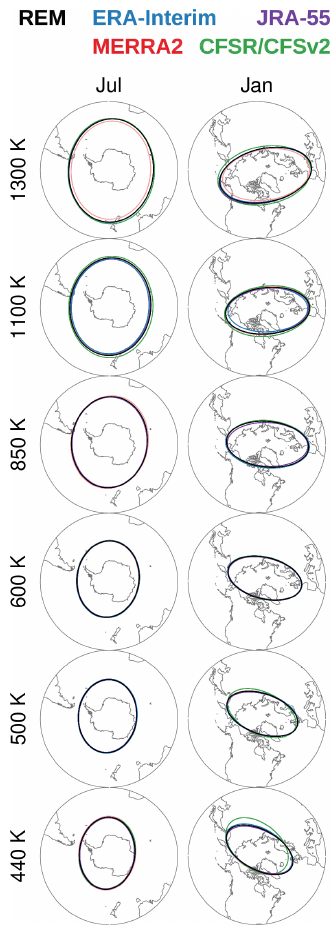
Figure 15. Polar stereographic plots of climatological monthly- mean equivalent ellipses from each reanalysis at several potential temperatures. July monthly mean equivalent ellipses for the South- ern Hemisphere (right); January equivalent ellipses for the Northern Hemisphere